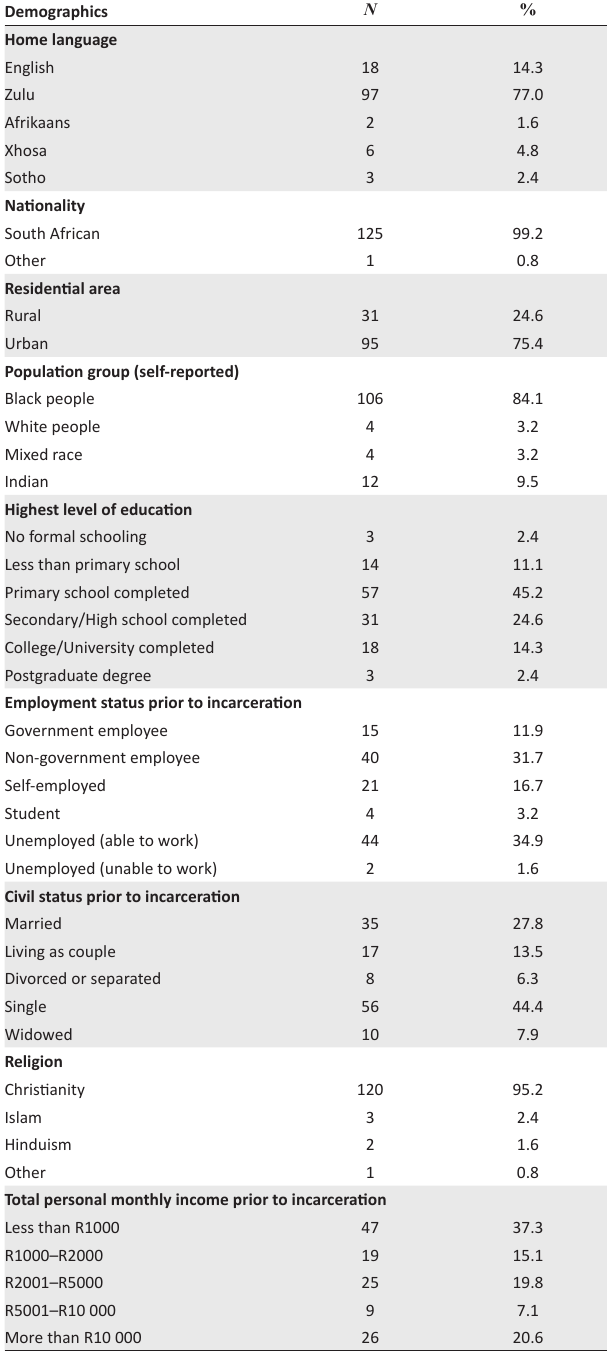
TABLE 1: Socio-demographic profile of 126 participants (SOs and